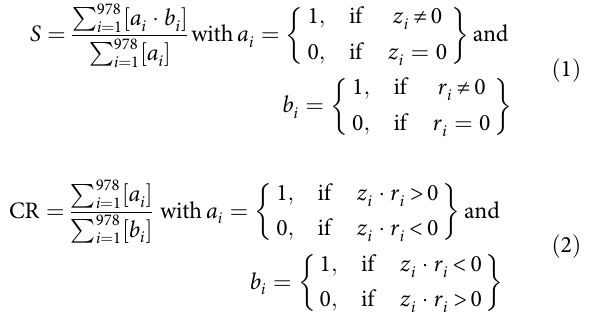
NATURE COMMUNICATIONS| (2018) 9:5315